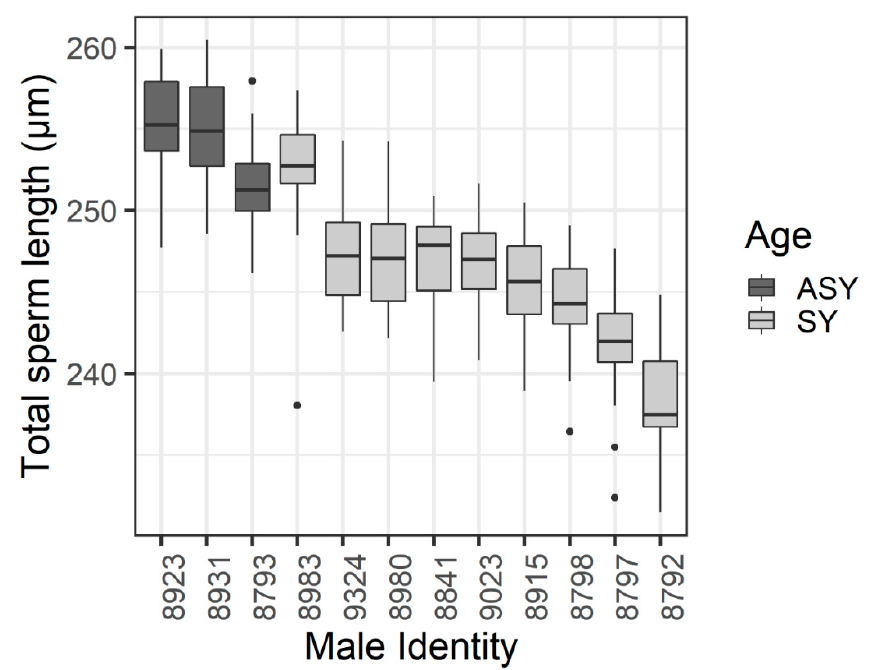
Figure 2. Sperm length from males in different age categories. Older males (in their second or later breeding season, ASY) are in dark grey, and young males in their first-breeding season (SY) are in light grey. Males are in order by total length within an age category. Boxplots show median, interquartile range (IQR), and greatest data extent within 1.5 × IQR, with more extreme data points indicated by dots. n = 20 cells per male.